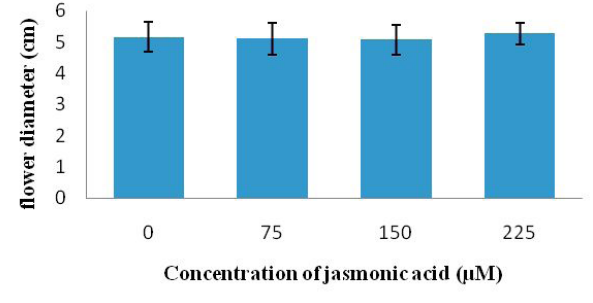
Fig. 2. Effect of different concentration of jasmonic acid on